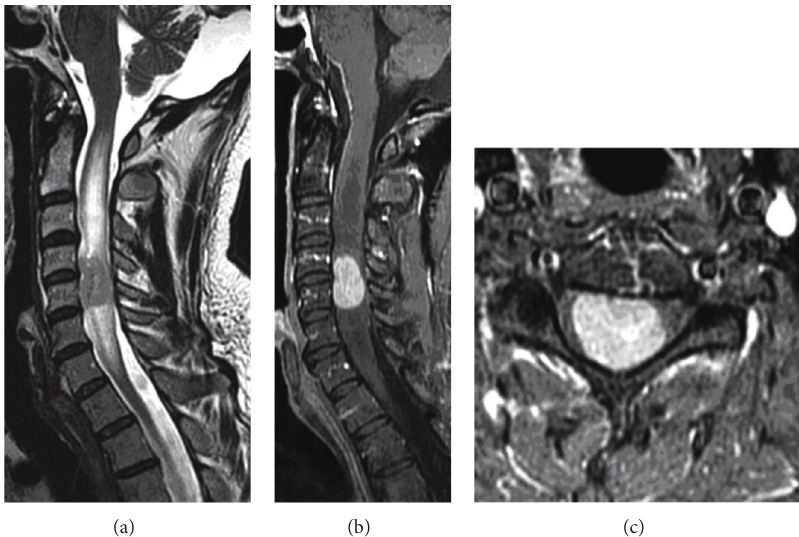
Figure 1: (a) Sagittal T2-weighted image of the cervical spine with an isointense lesion at C4-5 with surrounding T2 hyperintensity suggestive of edema. (b) Sagittal T1-weighted image with gadolinium enhancement showing an avidly enhancing lesion with surrounding cord edema. (c) Axial T1-weighted image with gadolinium enhancement revealing an intramedullary homogenously enhancing lesion with severe cord